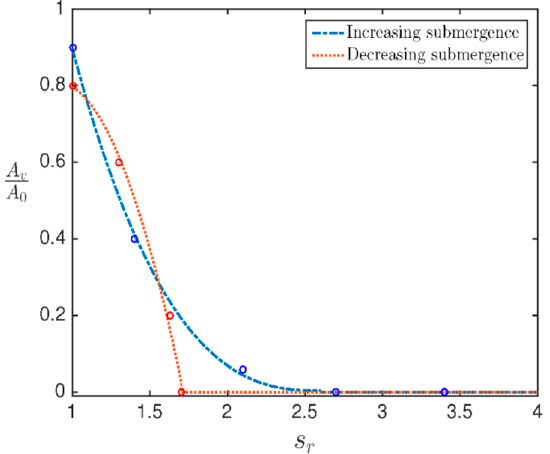
Figure 2. Ratio of ventilated propeller disk area to nominal disk area as function of propeller submergences ratios S r , Dalheim [14]. Submergence ratio is denoted by the symbol S r